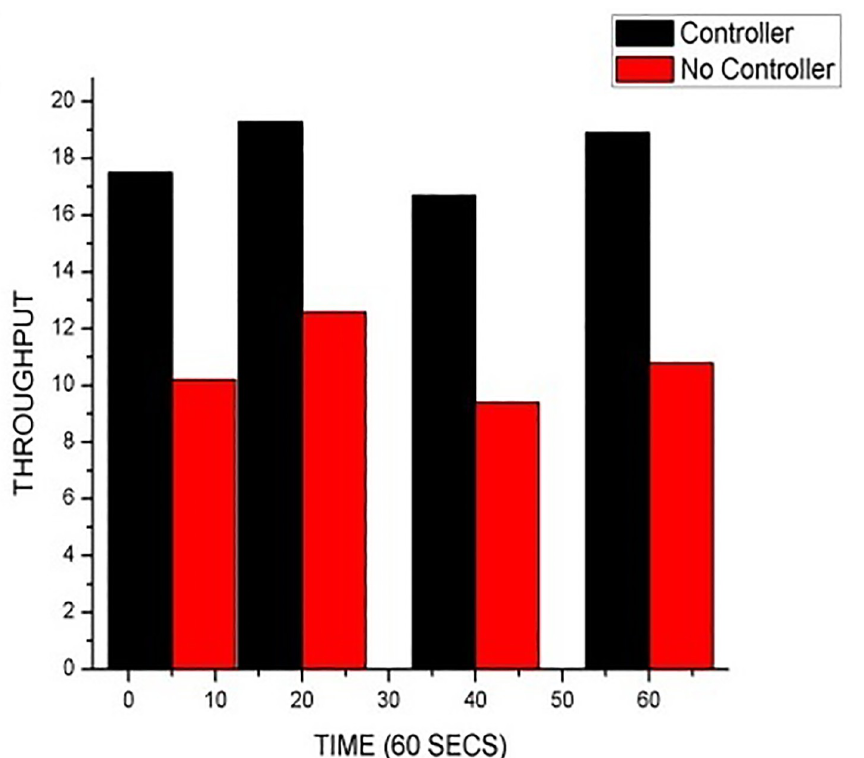
Fig 5. Throughput of 20 bytes transferred within 60 seconds.